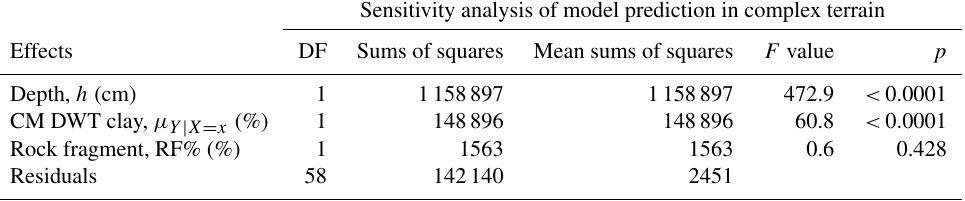
Table 4. Sensitivity analysis of model prediction in complex